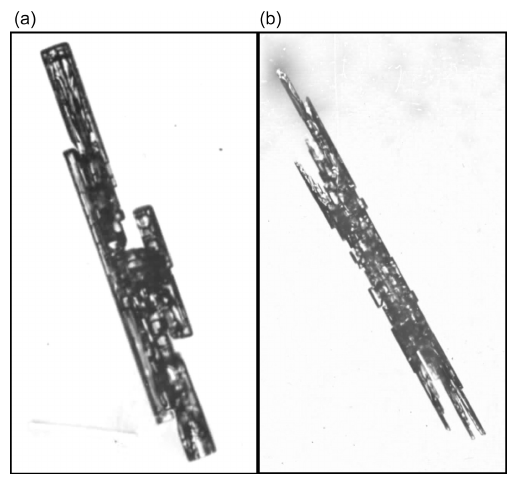
Figure B12. Bundle of sheaths (a) and bundle of needles (b) from the Magono–Lee collection (Magono and Lee,